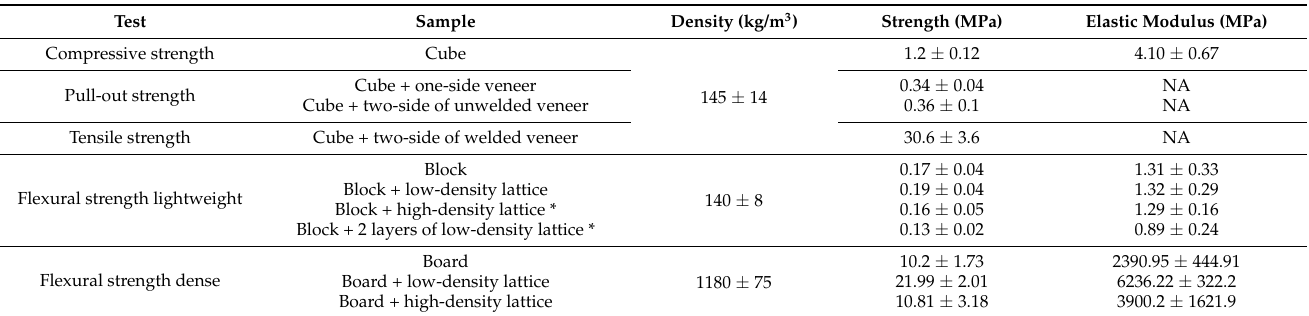
Table 1. Summary table for physical and mechanical properties of mycelium-based composites with and without veneer lattices.